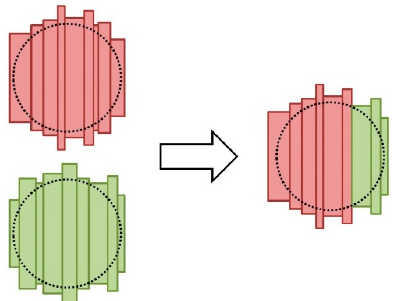
Figure 2. Procedure for applying the external crossing operator with two heads, with red and green staves. This procedure combines the staves of the two heads into a new head while attempting to maintain the positions of the staves and checking that the new distribution of the staves complies with the size requirements of the barrel